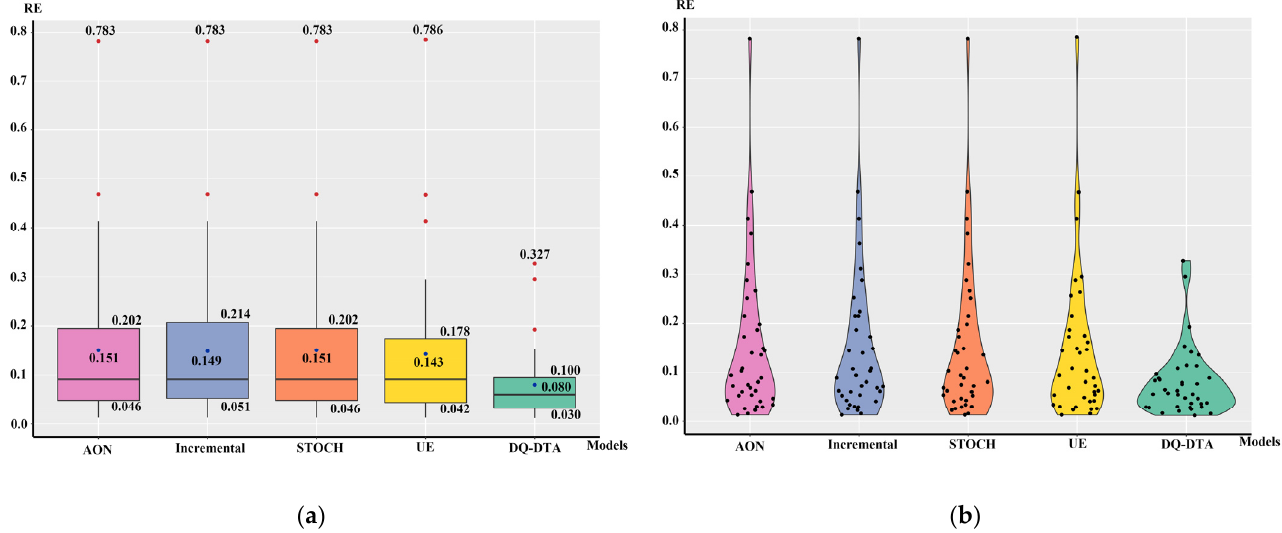
Figure 6. ( a ) The box plot of relative error distribution of observed links for the four classical models and the DQ-DTA model; red and blue points mean outliers and mean, respectively. ( b ) The scatter and violin plots of the relative error distribution of observed links for the four classical models and the DQ-DTA model.